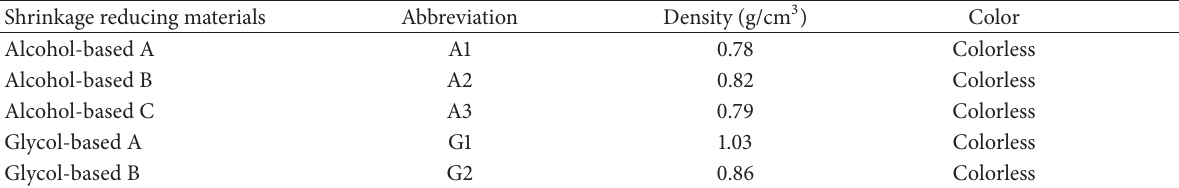
Table 2: Physical properties of shrinkage reducing materials in use.